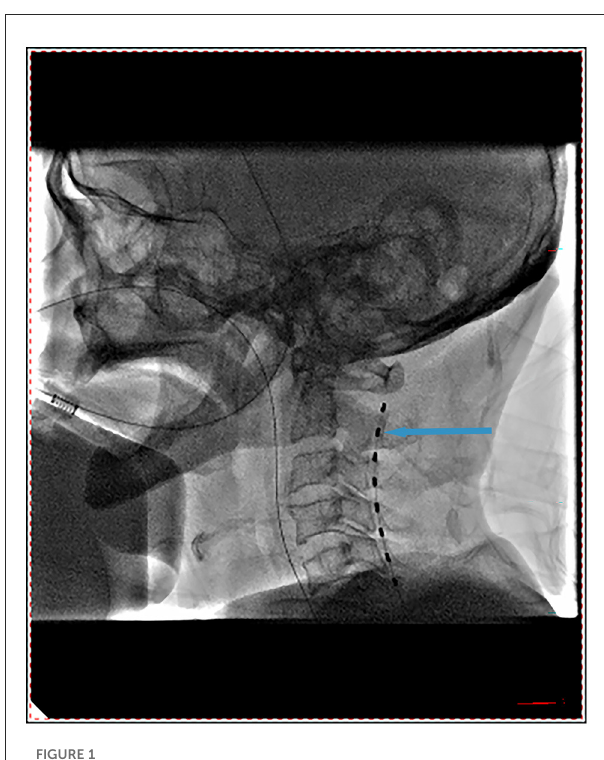
FIGURE1 Electrode position during the